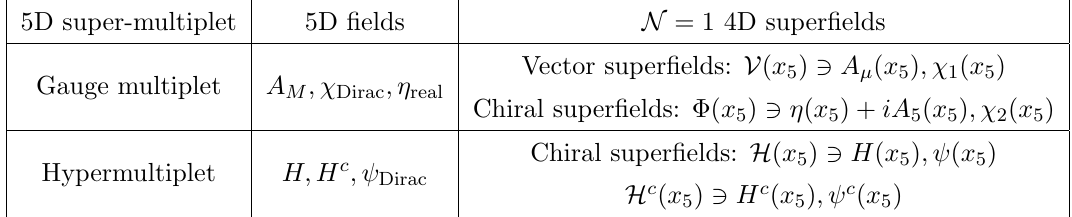
Table 1 . N = 1 5D SUSY in the N = 1 4D SUSY